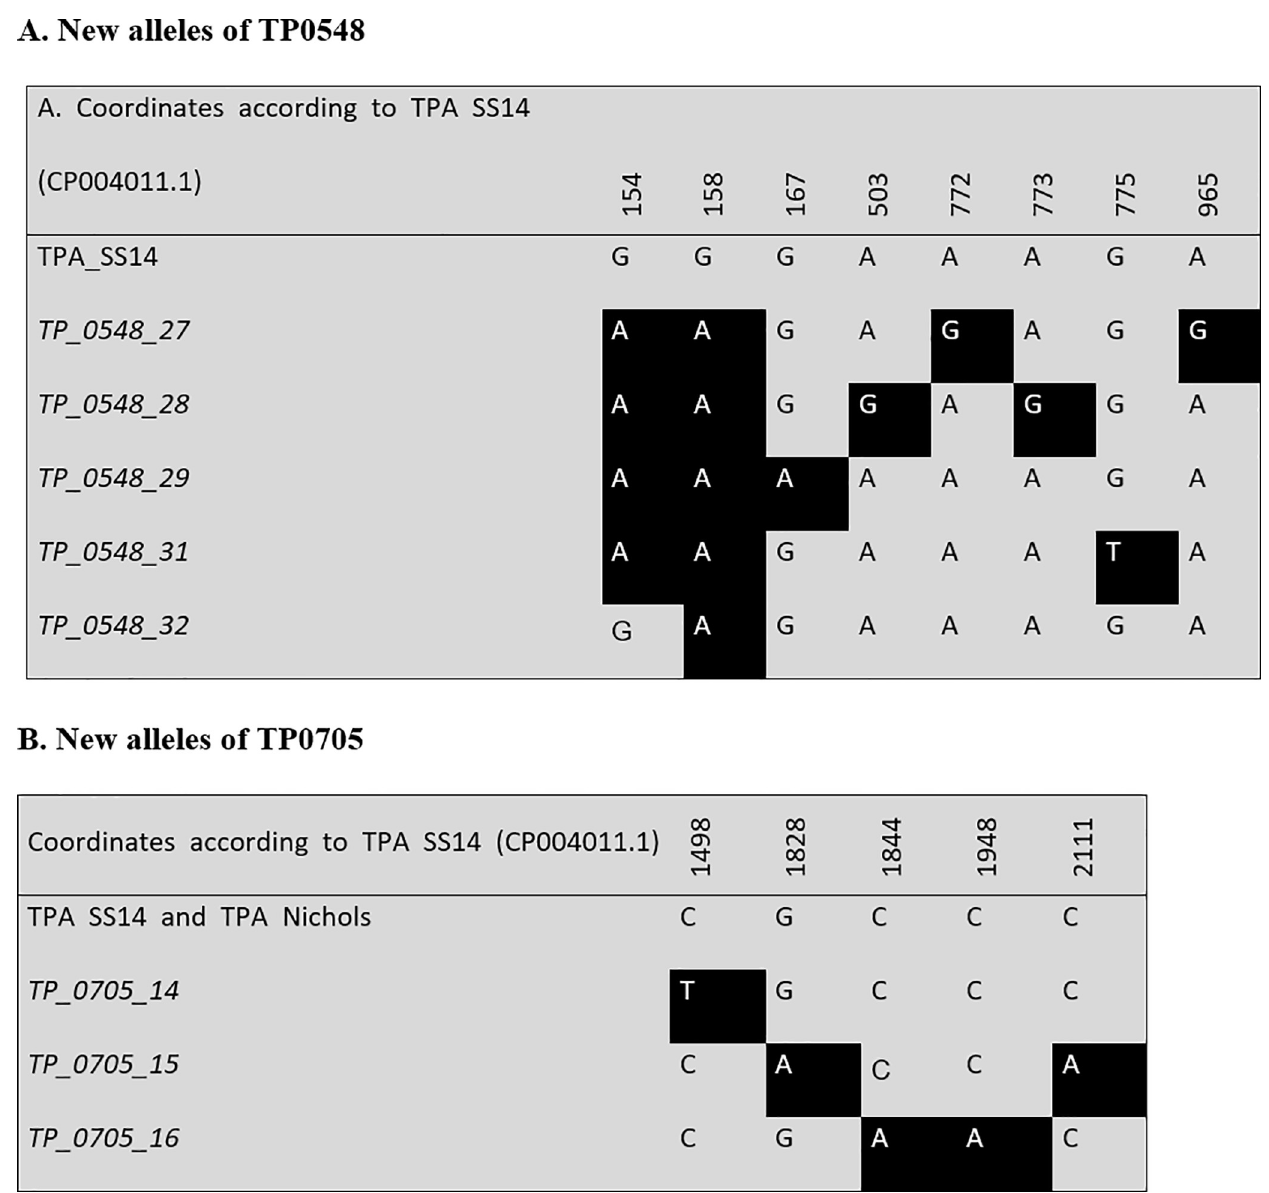
Fig 1. An alignment of the newly identified allelic variants. A. New alleles of TP0548. B. New alleles of TP0705. New alleles are in italics. A complete overview of allelic variants found in this study at the TP0136, TP0548, and TP0705 loci are shown in S1 Fig. No new alleles were found in the TP0136 locus.